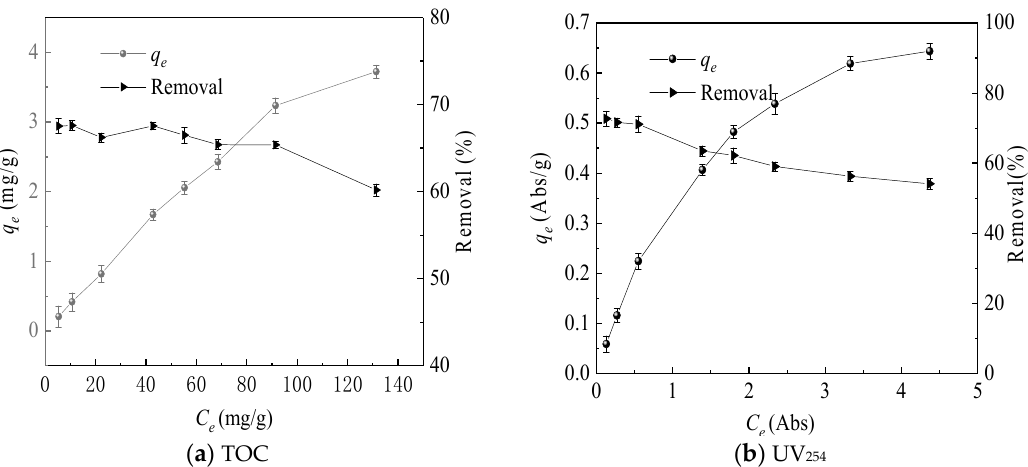
Figure 4. Adsorption isotherms and removal rate.